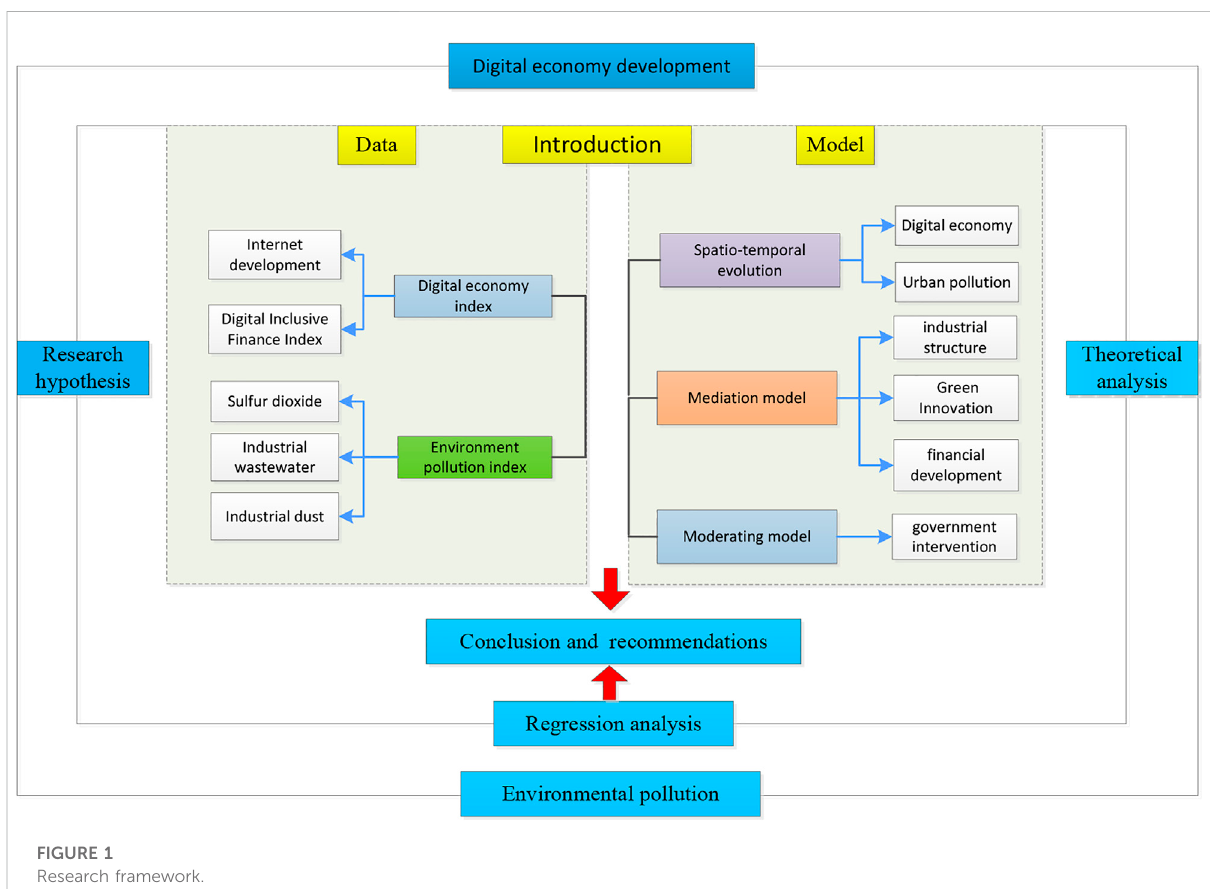
FIGURE 1 Research